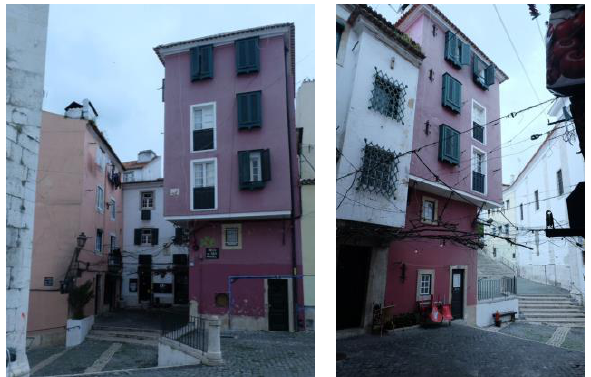
Figure 5. Current state of traditional overhanging dwelling in Beco de São Miguel no.17, Lisbon